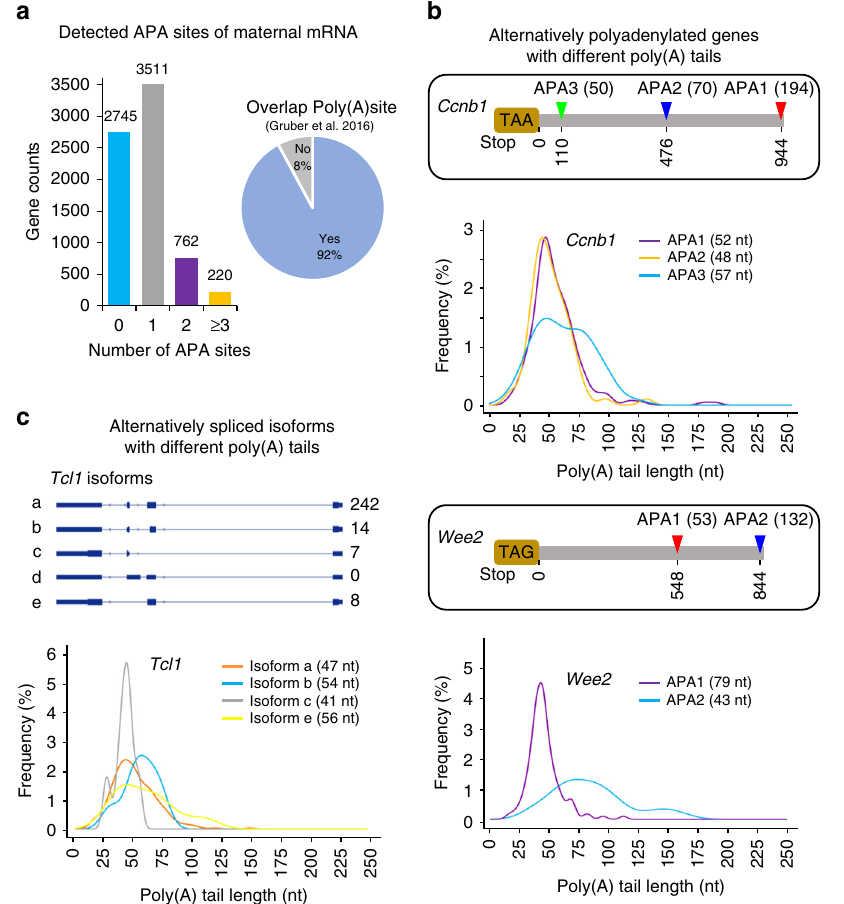
Fig. 3 PAIso − seq enables detection of isoform-speci fi c poly(A) tails. a Alternative polyadenylation (APA) events (left panel) of maternal transcripts in GV oocytes detected by PAIso − seq and compared with reference poly(A) site (right panel) 45 . b Two maternal genes, Ccnb1 (with three polyadenylation sites, p = 0.0067 between APA2 and APA3) and Wee2 (with two polyadenylation sites, p = 3.9e − 12 between two APA) with APA isoform-speci fi c poly(A) tails. The number of APA isoforms are shown at the right of APA model. The mean length of poly(A) tails from isoforms of different polyadenylation sites is shown at the graph. The p value was calculated by unpaired and two-sided Student ’ s t test. The number of CCS reads used are 194 ( Ccnb1/ APA1), 70 ( Ccnb1/ APA2), and 50 ( Ccnb1/ APA3); 53 ( Wee2/ APA1) and 132 ( Wee2/ APA2). c Different alternative splicing isoforms of Tcl1 mRNA have different length of poly(A) tails. The gene model and captured isoforms (top) of Tcl1 . The number of detected isoforms are shown on the right. The poly(A) tail length of detected isoforms is shown in the bottom. The mean length of each isoform poly(A) tail is shown. p = 0.03791 between isoform a and c; p = 0.014 between isoform b and c. The p value was calculated by unpaired and two-sided Student ’ s t test. The number of CCS reads used are 242 (isoform a), 14 (isoform b), 7 (isoform c), and 8 (isoform